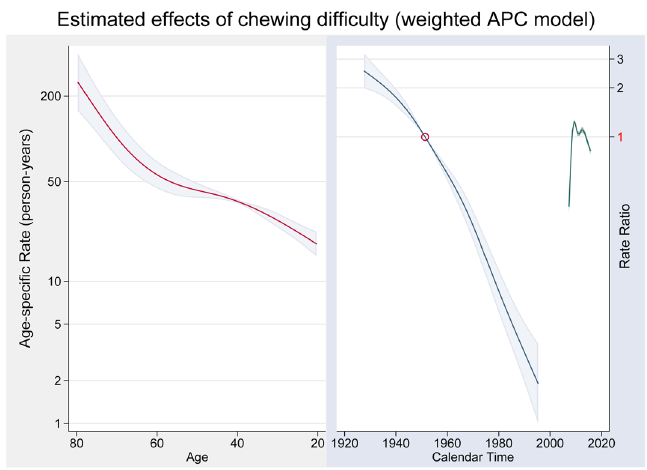
Figure 2. APC model estimation of chewing difficulty. Age-specific chewing difficulty, referenced to 1951. The regions surrounding the lines provide 95% confidence